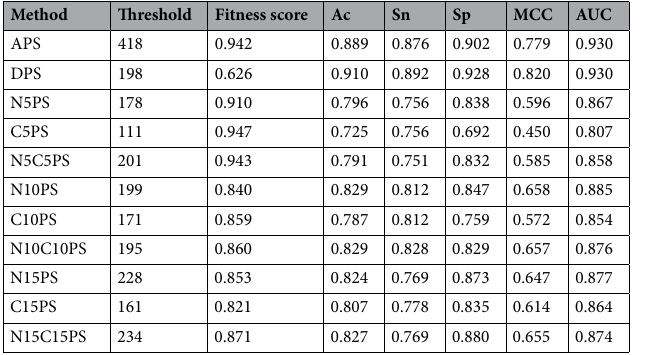
Table 4. Independent test results of FSCM models with various types of sequence features as evaluated on the alternative dataset.